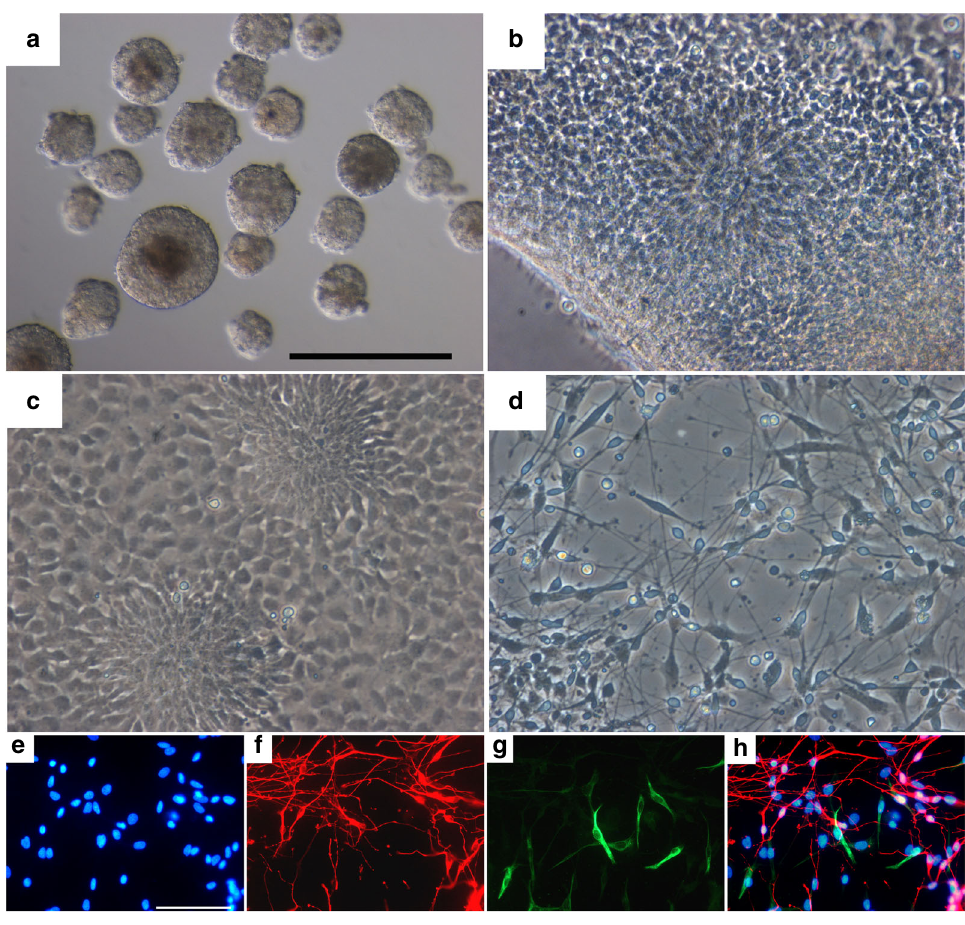
Fig. 4 Bright- fi eld panel of neural differentiation. a Embryoid bodies, 4 days after derivation from proliferating rESC. b Neural rosettes. c Proliferating neural precursors with areas of residual radial cells. d Differentiated neurons. Scale bar corresponds to 100 μ m. Staining for neural differentiation obtained by embryoid body formation and subsequent induction of differentiation. e Hoechst staining of the nuclei, f differentiated neurons stained with TUJ1 , g Peripherin staining, and h merge (see also ref. 21